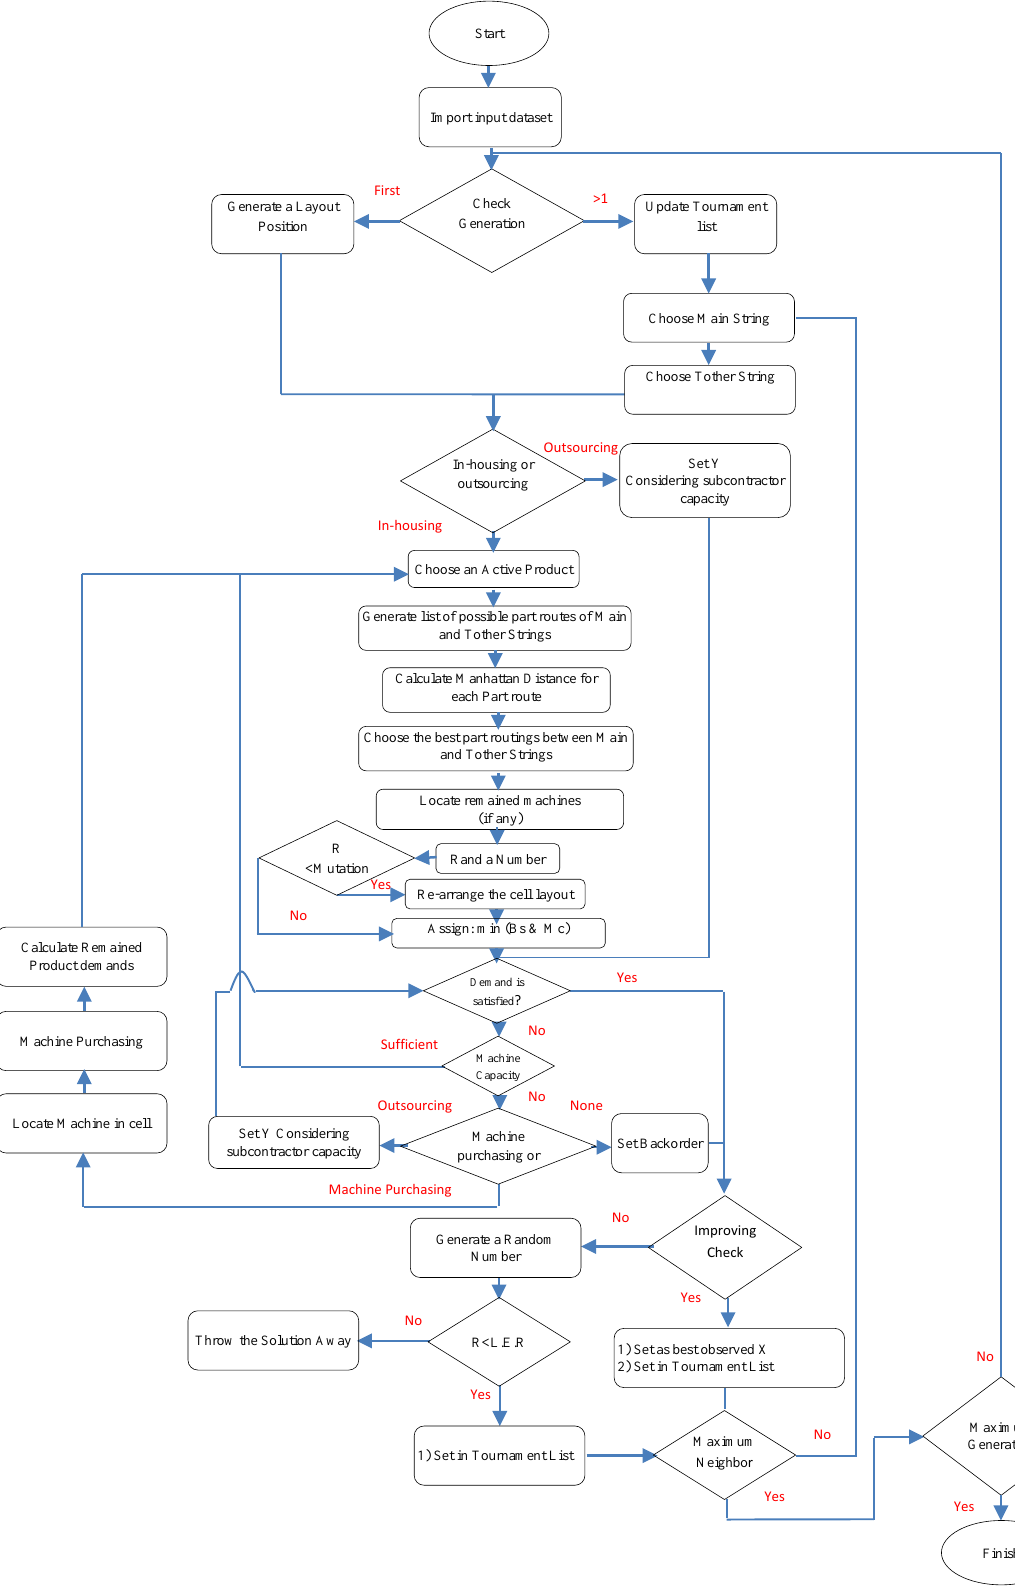
Fig. 4. Flowchart of the proposed genetic algorithm for solving the proposed